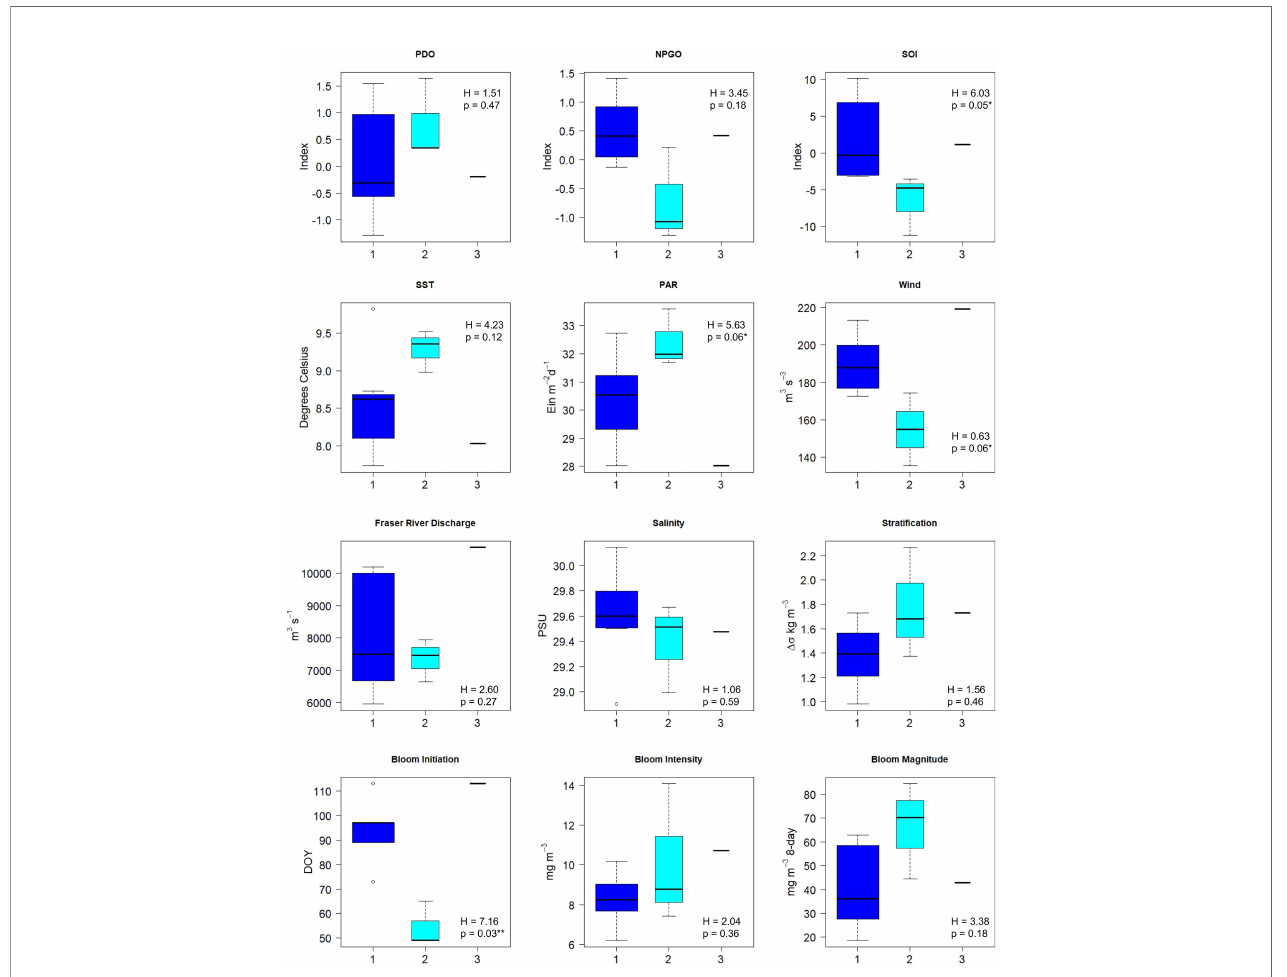
FIGURE 11 | A comparison of large-scale climate indices, environmental parameters, and bloom dynamics between clustering groups for the Central Strait of Georgia crustacean community from 2003-2016. Group 1= dark blue boxplots, Group 2= light blue boxplots, Group 3= black lines representing a single year. P- values and H-statistics were determined using non-parametric Kruskal-Wallis test. D.f. = 2 for each test; **=signi fi cant at alpha=0.05, *=signi fi cant at